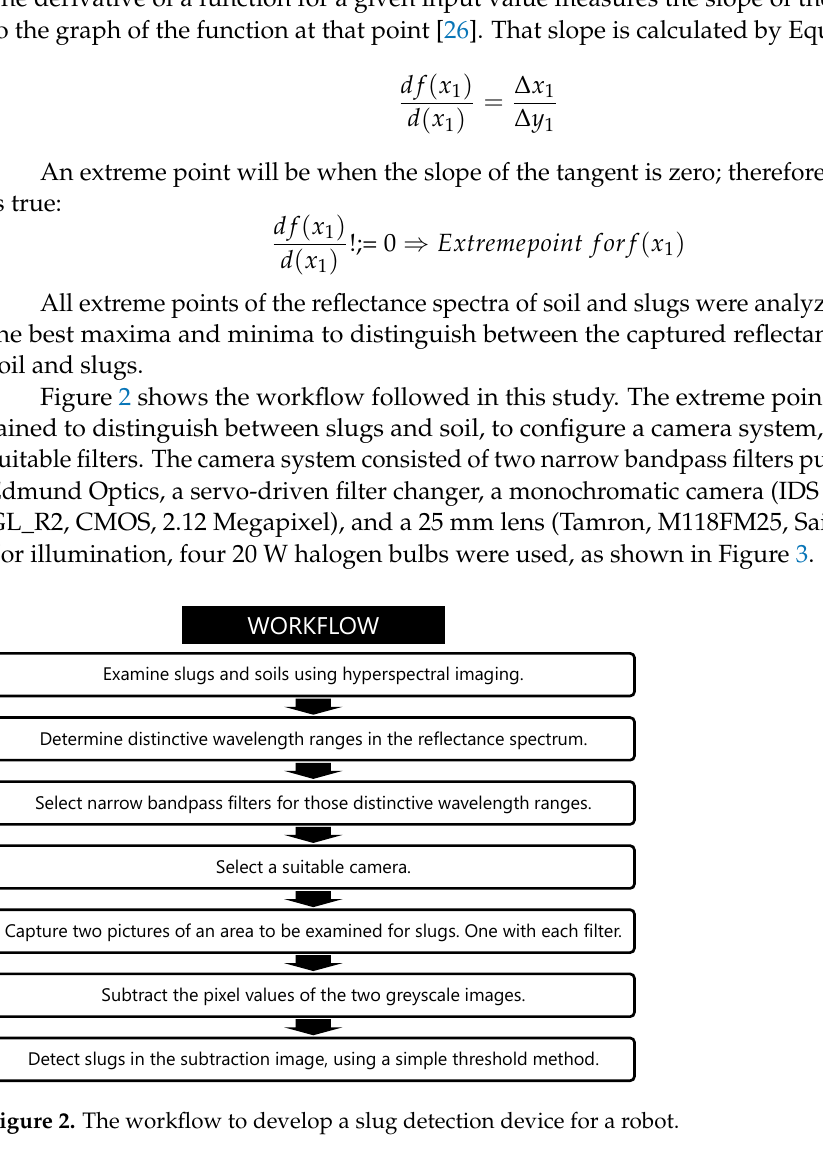
Figure 2. The workflow to develop a slug detection device for a robot. To take further factors that impact on the measured relative reflectance, polynomial regression of these factors was used. Polynomial regression is a modelling of the different independent variables and their dependent variables as a multi-dimensional